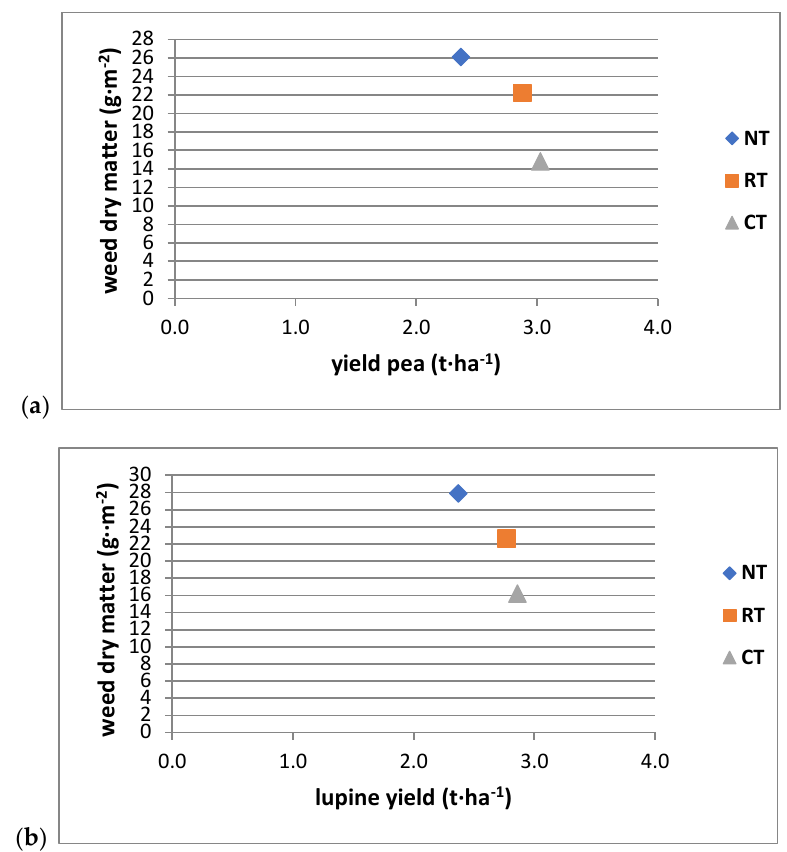
Figure 6. Relation between weeds dry matter seeds and yield of ( a ) pea, ( b ) legume.